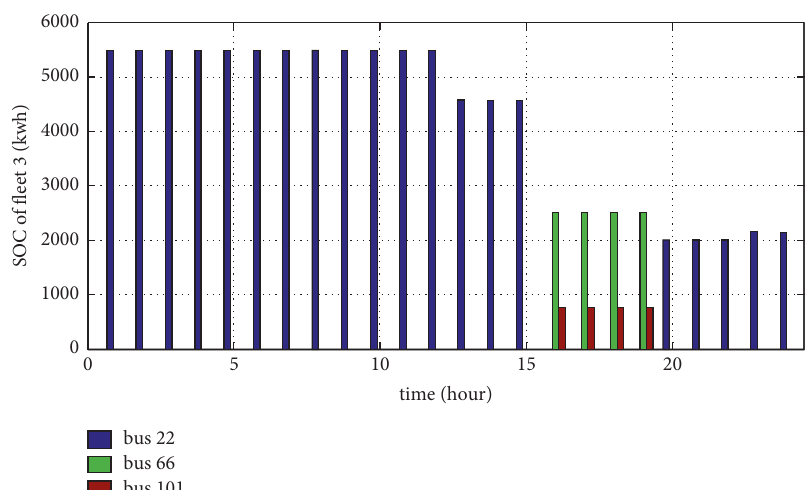
Figure 17: SOC of PEV fleet 3 in case 3 (the first